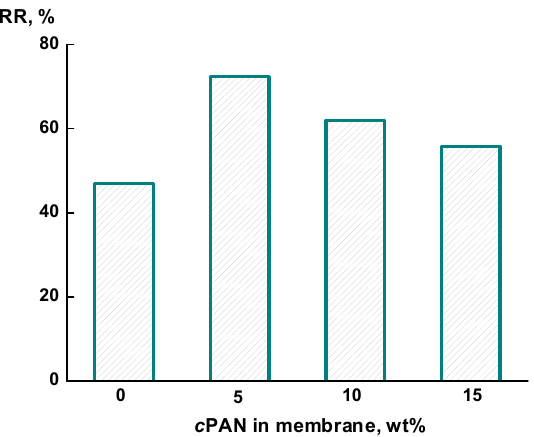
Figure 8. Dependence of proteins’ rejection on their molecular weights for PAI- c PAN membranes.